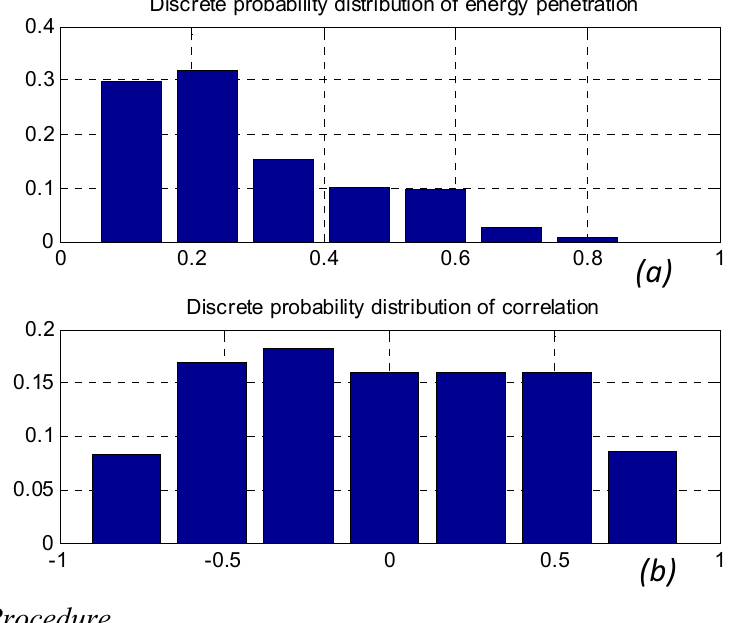
Figure 8. ( a ) Discrete probability distribution of daily wave energy penetration, r Case 2 ( N = 49 scenarios); ( b ) Discrete probability distribution of daily cross-correlation between wave generated power and power consumption, c , for Case 2 and Case 1 ( N = 49